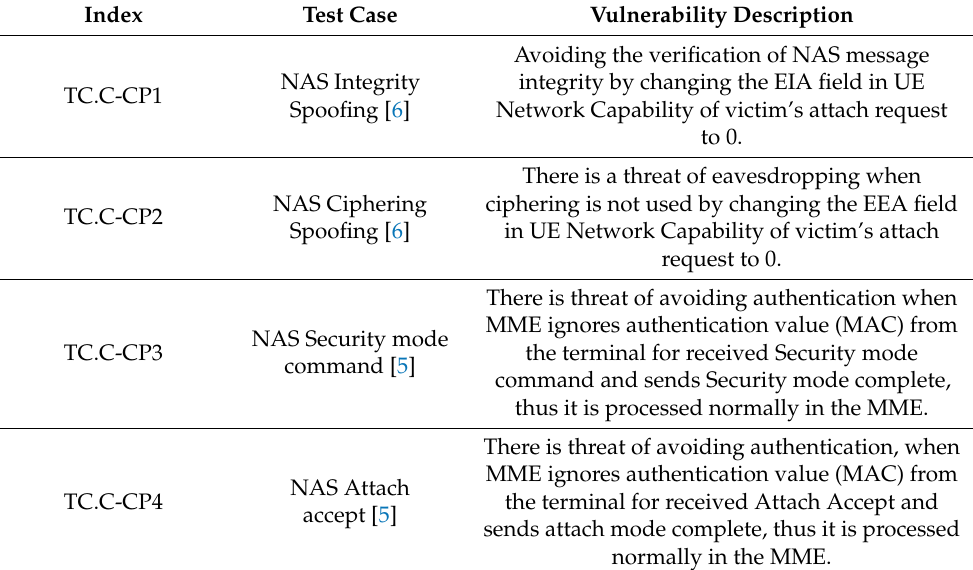
Table 4. CN CP security threat test cases.